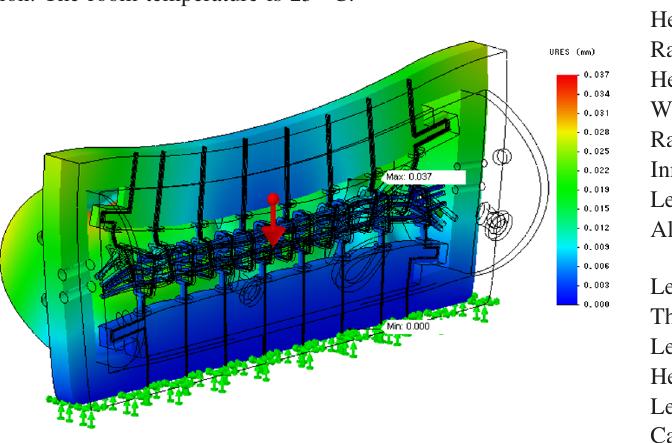
FIG. 9. Temperature distribution in the heat-transfer simula- tion. The room temperature is 25 (cid:4) C.